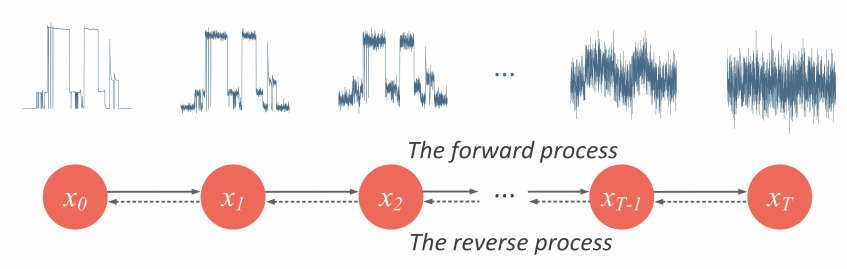
Figure 1. Illustration of the forward process and the reverse process in a NILM task. The pink arrows point out the process of forward diffusion, where a clean power pattern is gradually destroyed. The green arrows indicate the process of denoising inference, where the target waveform is recovered.